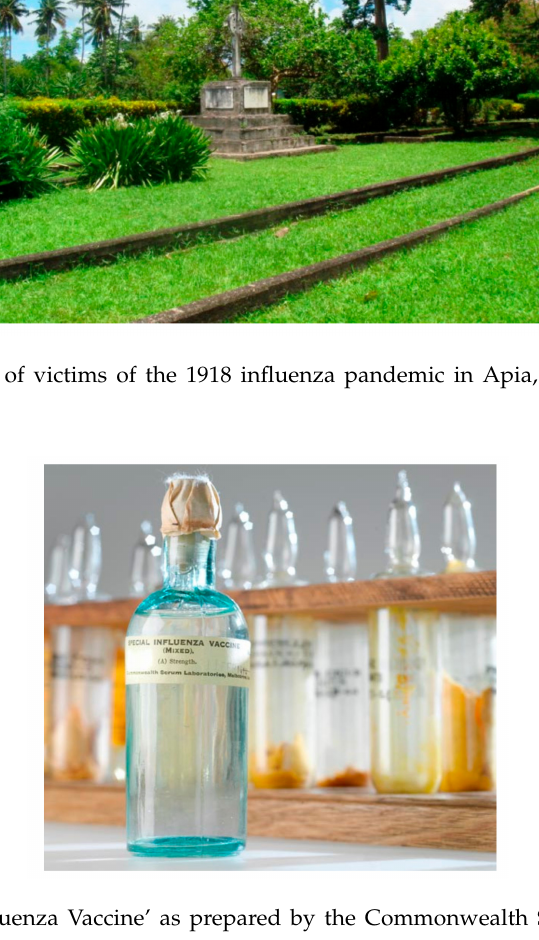
Figure 3. ‘Special Influenza Vaccine’ as prepared by the Commonwealth Serum Laboratories in Australia in 1918 and used for the crew of HMAS Encounter during operations in Samoa. Photo by Michelle McFarland and copyright held by Museums Victoria as item